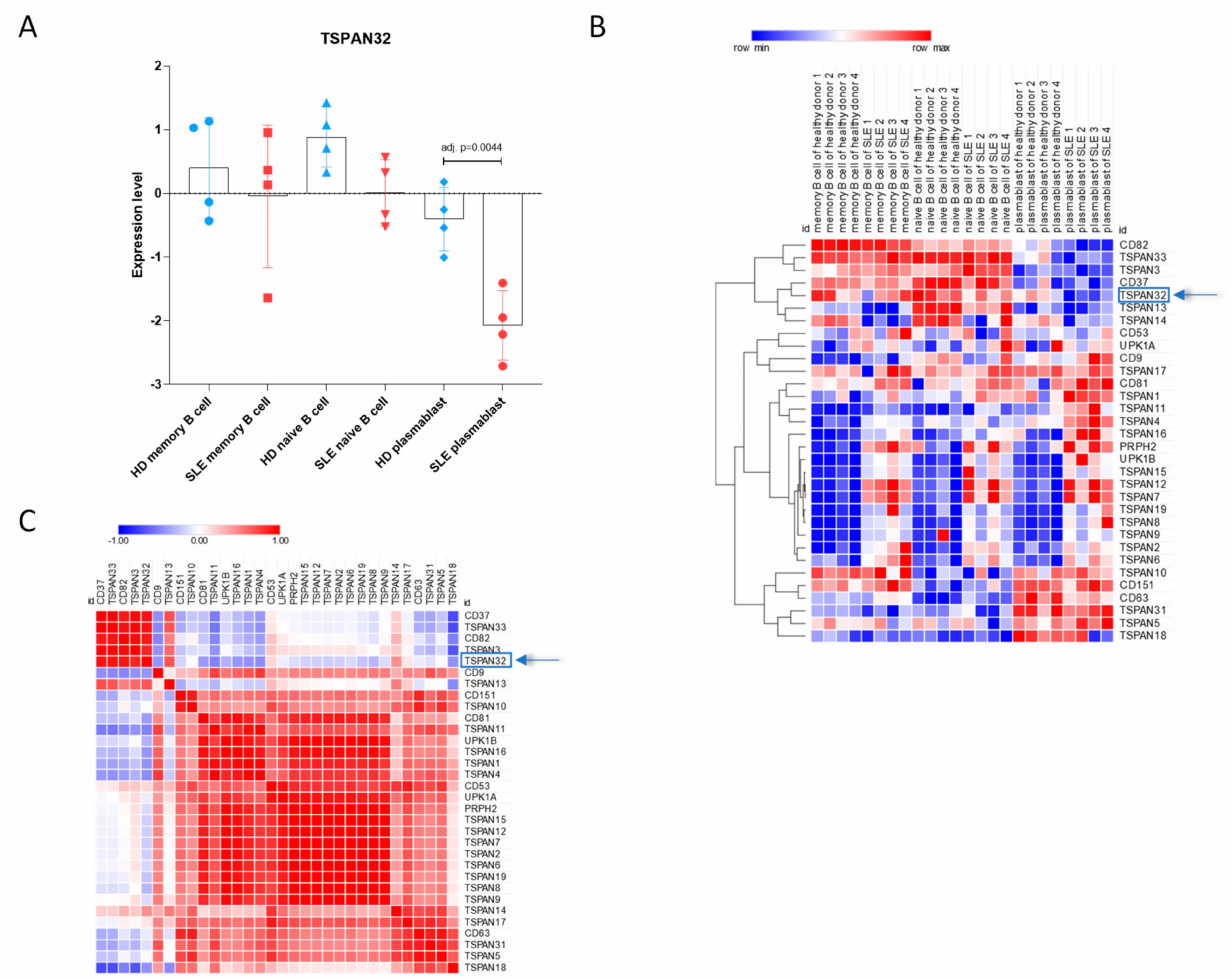
Figure 2. Transcriptional levels of TSPAN32 in B cell subpopulations from SLE patients. The expression levels of TSPAN32 and of the related family of tetraspanins in B cell subpopulations from 4 SLE patients and 4 healthy donors were obtained from the GSE156751 dataset. ( A ) TSPAN32 levels in naive B cells, memory B cells, and plasmablasts from SLE patients and healthy donors. ( B ) Heatmap showing the expression levels of TSPAN32 and related tetraspanins in naïve B cells, memory B cells, and plasmablasts from SLE patients and healthy donors. ( C ) Gene similarity matrix for all the analyzed tetraspanins calculated using the spearman rank correlation, as similarity metrics, on the samples included in the GSE156751